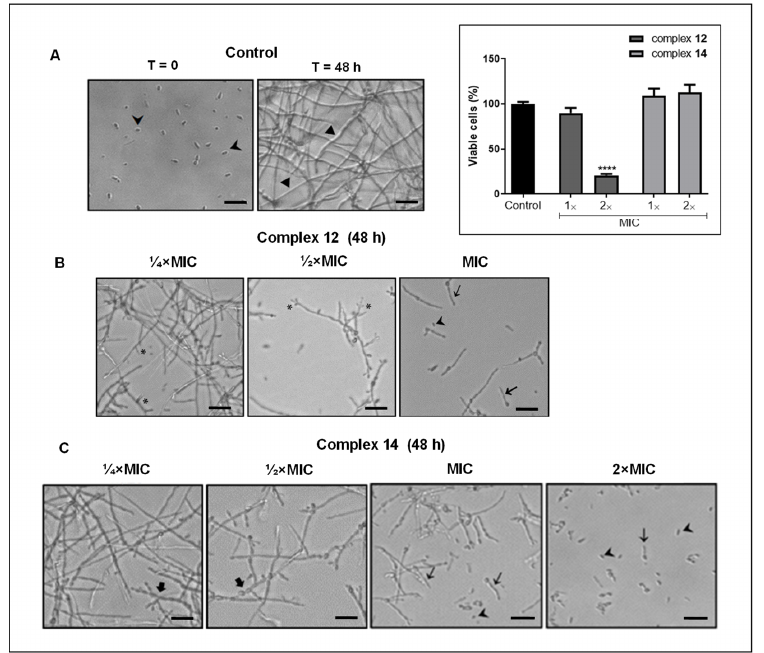
Figure 3. Effect of silver complexes on F. pedrosoi differentiation. ( A ) Control systems, conidia ( (cid:228) ) in RPMI medium before (Time zero, T = 0) and after 48 h of incubation (T = 48 h), when filamentous form ( (cid:73) ) was produced; ( B ) Conidia treated with 1 / 4 and 1 / 2 MIC of complex 12 had the ability to branch (*) and form hyphae ( (cid:73) ) inhibited after 48 h. In the MIC concentration, germ tubes ( → ) and conidia ( (cid:228) ) were especially observed; and ( C ) Complex 14 ( 1 / 4 and 1 / 2 MIC) inhibited hyphae formation, but moniliform cells ( (cid:225) ) were found. While in the MIC and 2 × MIC values, germ tubes ( → ) and conidia ( (cid:228) ) were the most often detected. Bar: 10 µ M. ( Inset ): The graph shows the viability of conidia after treatment with complexes using XTT assay [52]. **** p < 0.05.